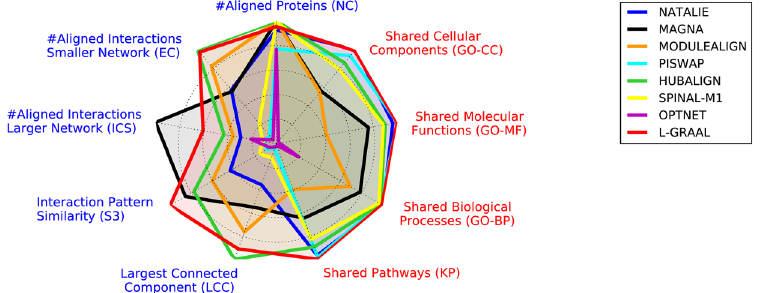
Figure 2. Comparing network aligners. Network aligners (coloured lines) are compared according to the best scores that they achieve when aligning the 16 pairs of networks (presented values are the averages of the 16 scores, normalized in [0,1] according to the best performers). Aligners are compared according to the nine scoring schemes: the five blue ones (on the left) are topology-based, while the four red ones (on the right) are biology-based (see definitions in Methods). The closer an aligner is to the border of the radar chart, the better it performs according to the corresponding score.